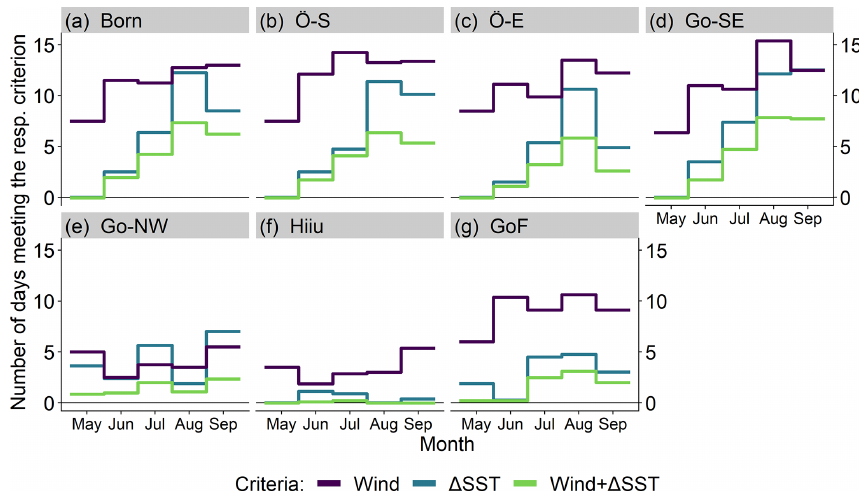
Figure 5. Overview of the two upwelling criteria used in this study: wind (purple) and (cid:49) SST (blue). Displayed is the number of days per month and box in which the respective criterion is met, averaged over 2010 to 2017. (cid:49) SST was calculated along the route of SOOP Finnmaid through the boxes (Sect. 2.3; second approach) to display events that are actually observable from the ship. “Wind + (cid:49) SST” (green) only applies to instances of both criteria being met on the exact same day and therefore excludes occasional instances of lag between wind and (cid:49) SST signals. The openGo box is not included here since no upwelling-favourable wind direction can be